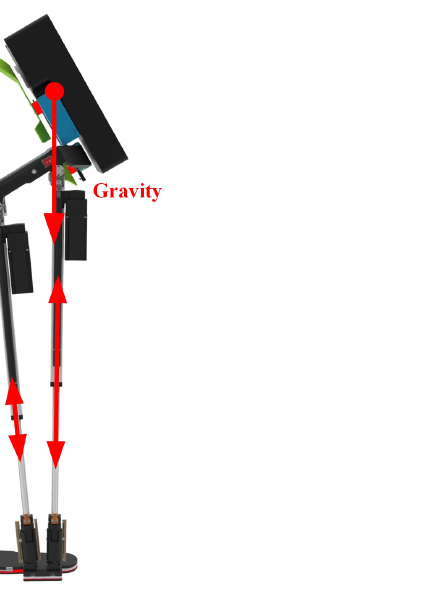
Figure 6. Process of adjusting COM at the initial moment when PALExo is